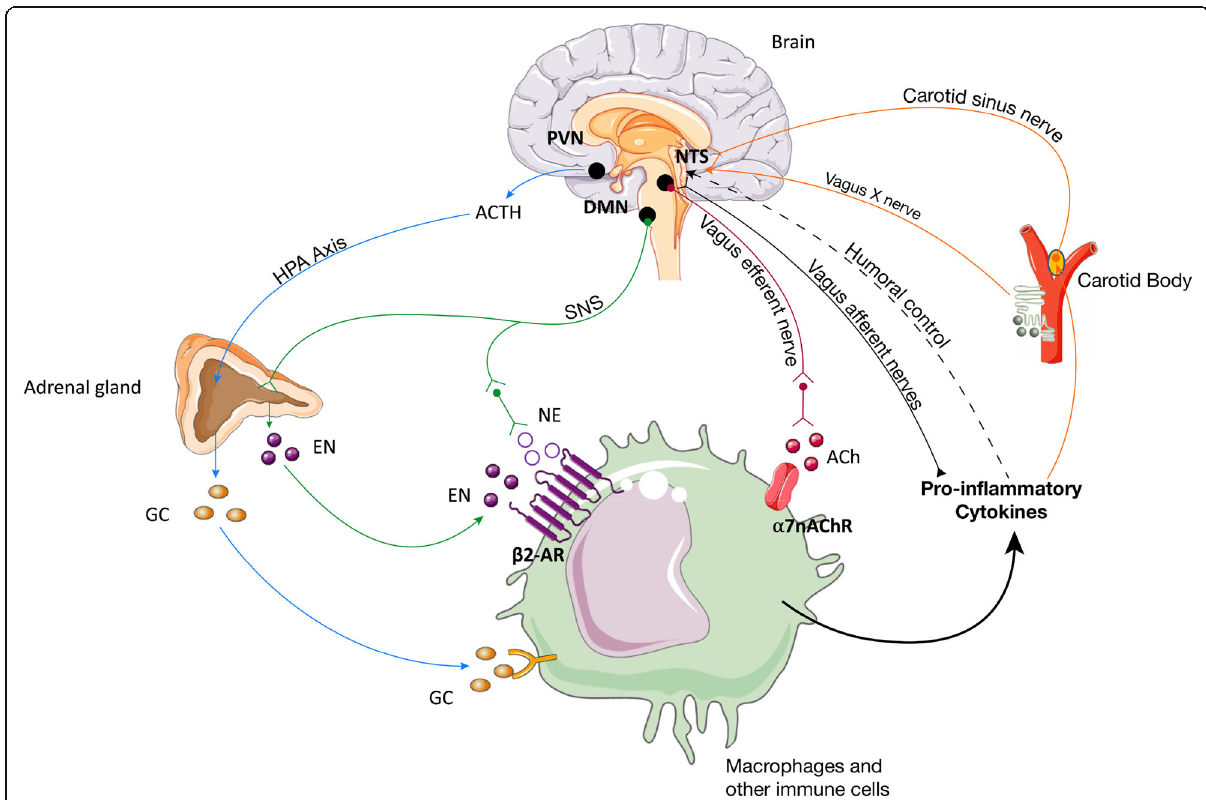
Fig. 1 Neuronal reflexes controlling inflammation. The HPA axis is activated by several stimuli to activate the paraventricular nucleus (PVN) of the hypothalamus leading to the release of cortisol releasing hormone (CRH) into the anterior pituitary. In turn, CRH induces the release of adrenocorticotrophic hormone (ACTH) in blood, which stimulate the production of glucocorticoids (GC) by the cortex of the adrenal glands, which are potent anti-inflammatory molecules whose effect is mediated by the signaling via glucocorticoid receptor (GR), a nuclear receptor expressed by almost all cells in the body and in particular in innate immune cells; Vagal anti-inflammatory reflex is characterized by peripheral vagal afferent nerves detecting inflammation and sending this information to the CNS. Reciprocal connections between the NTS and DMN mediate communication with and activation of efferent vagus nerve fibers inducing the release of ACh and ultimately attenuating cytokine production and inflammation through a mechanism, based on the binding of ACh on nicotinic α 7nAChR; Additionally, these cytokines can also activate directly this region in the brain by a humoral control in order to revert inflammation; Sympathetic fibers originating in the spinal cord terminate innervate directly visceral organs and immune cells and release norepinephrine (NE) that binds to its specific receptors on these cells. Efferent sympathetic output to the adrenal gland induces the secretion of epinephrine (EP) from chromaffin cells that circulates in blood to reach specific receptors in immune cells. EN and NE joint action stops inflammation and release of inflammatory cytokines; finally, inflammation resolution also occurs through carotid body (CB) action. Briefly, released inflammatory mediators by immune cells activate the CB, which in turn activates carotid sinus nerve (CSN) that projects within the nucleus tractus solitarii